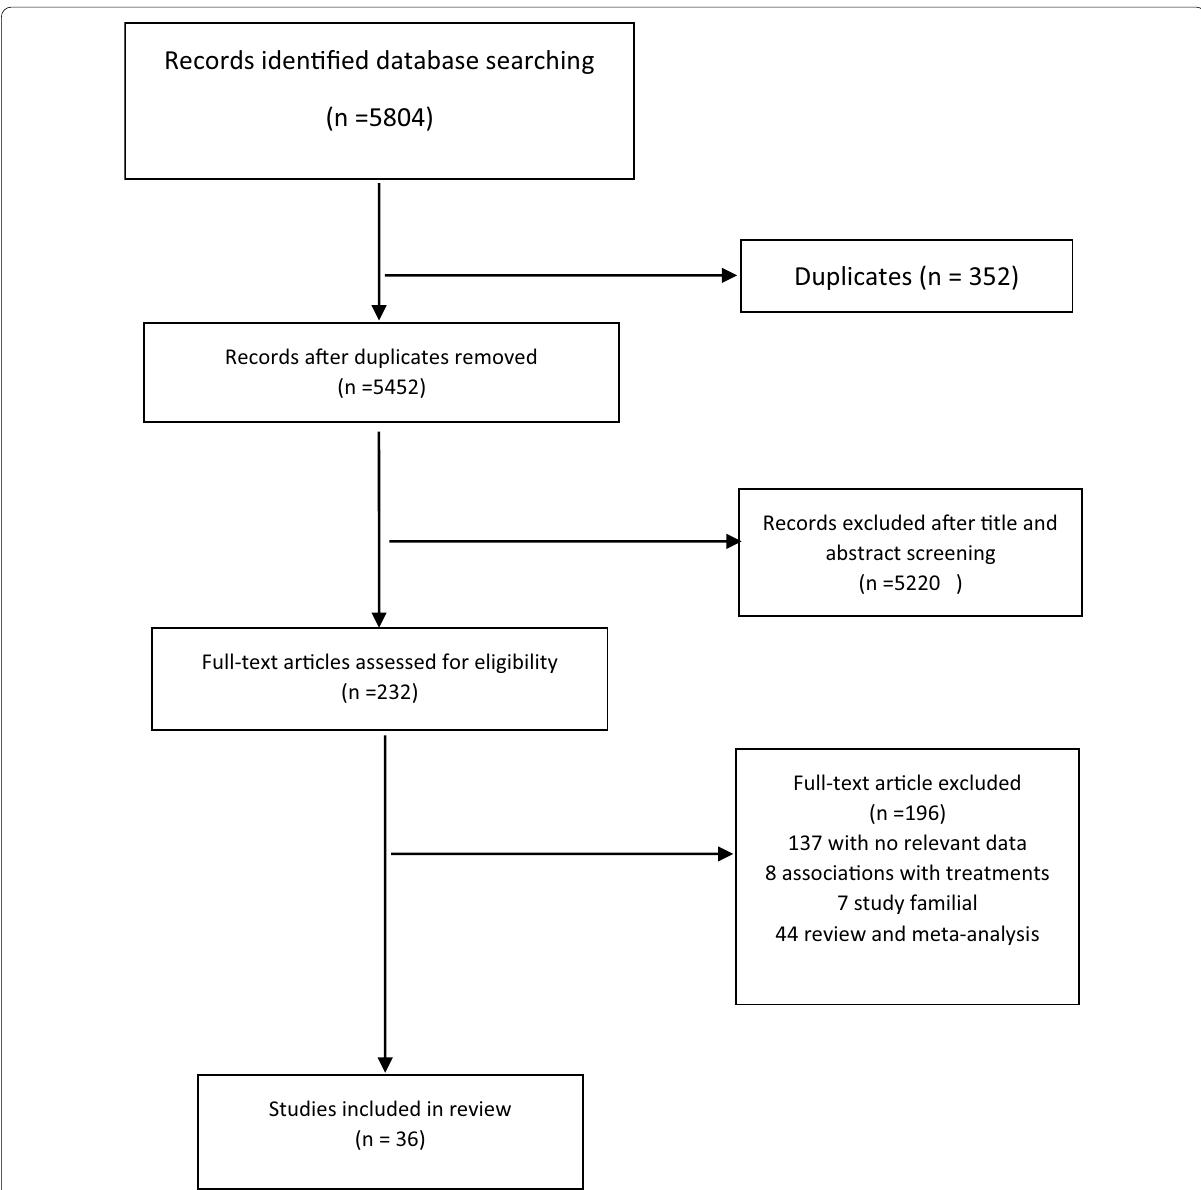
Fig. 1 Preferred reporting items for the systematic reviews and meta-analysis